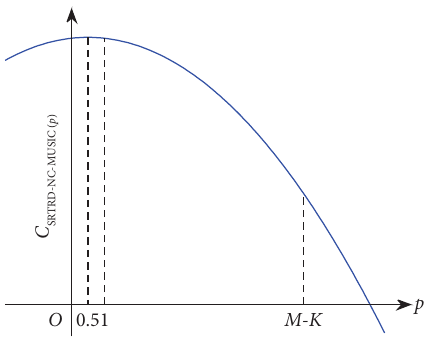
Figure 2: Analysis of the value of C